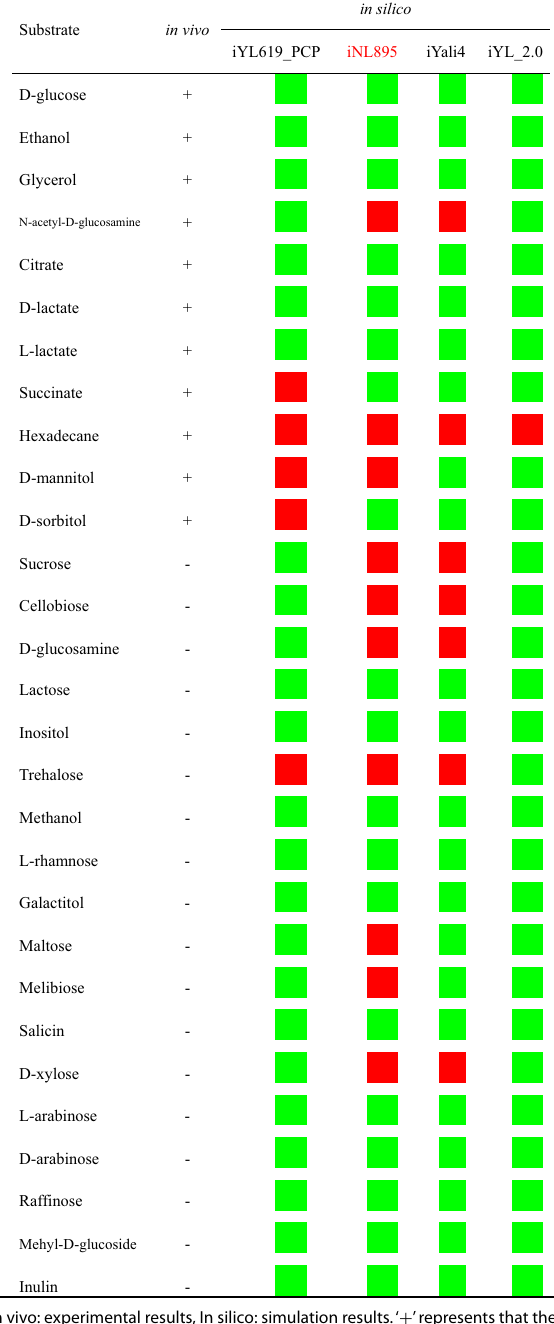
Table 3 Comparison between simulated results by four models and experimental results on the utilization of dif- ferent carbon sources in Y.